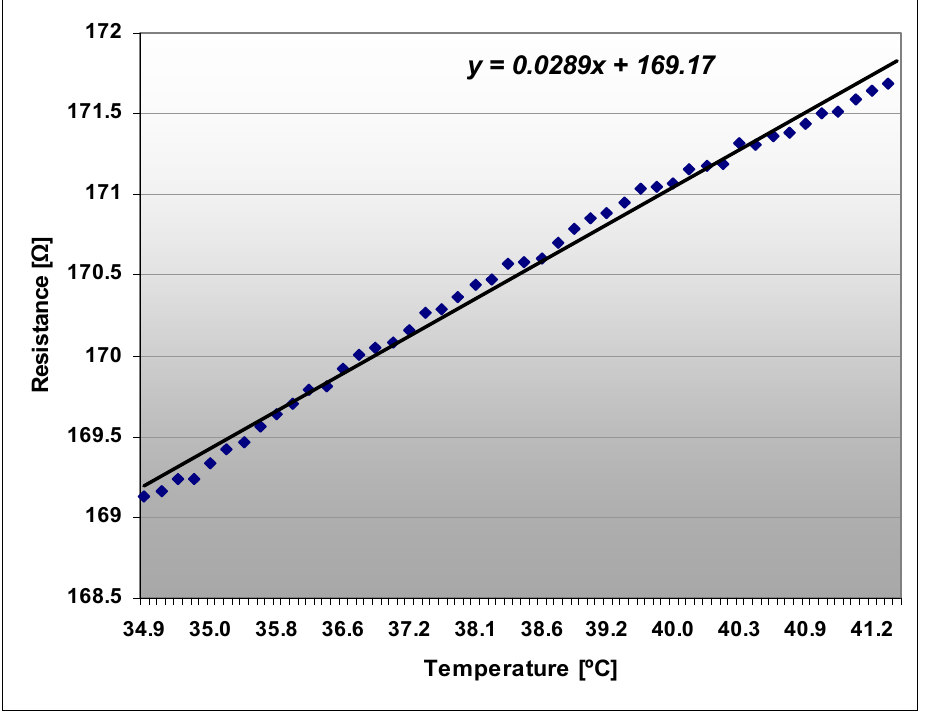
Figure 11. Temperature sensor diagram, resistance versus temperature in a water based solution.